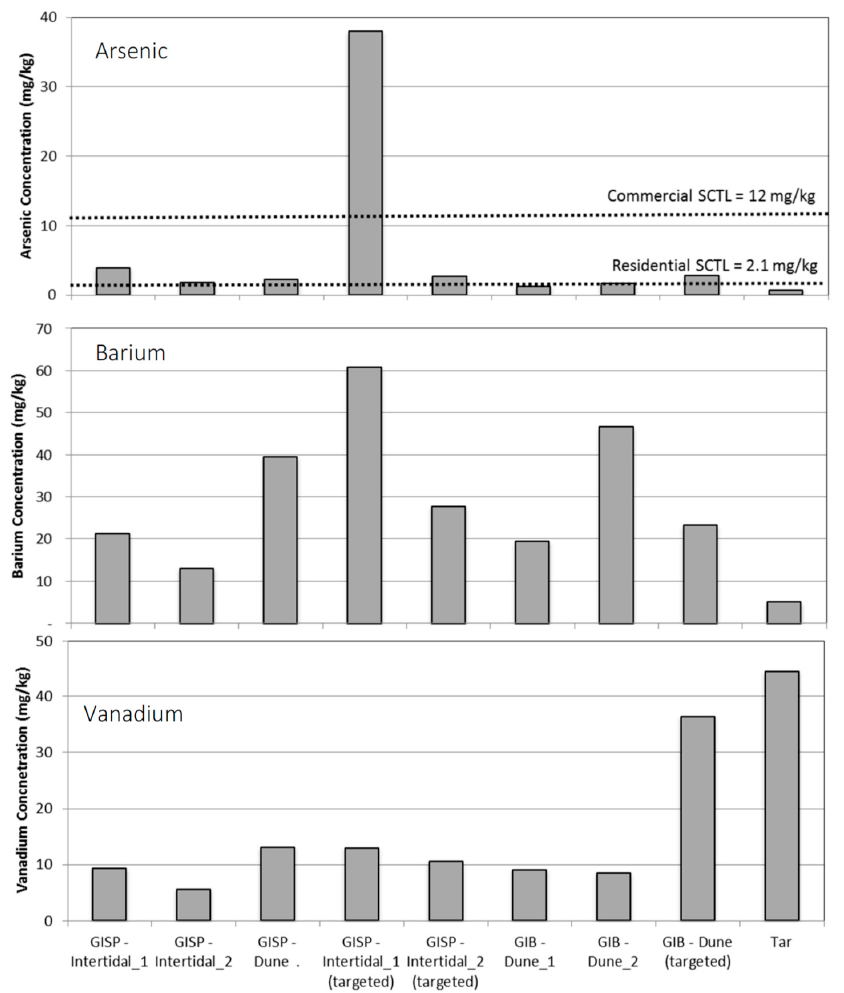
Figure 1. Arsenic, barium, and vanadium levels (mg/kg) in samples collected from Gulf Island State Park (GISP) and from Gulf Island Beach (GIB).